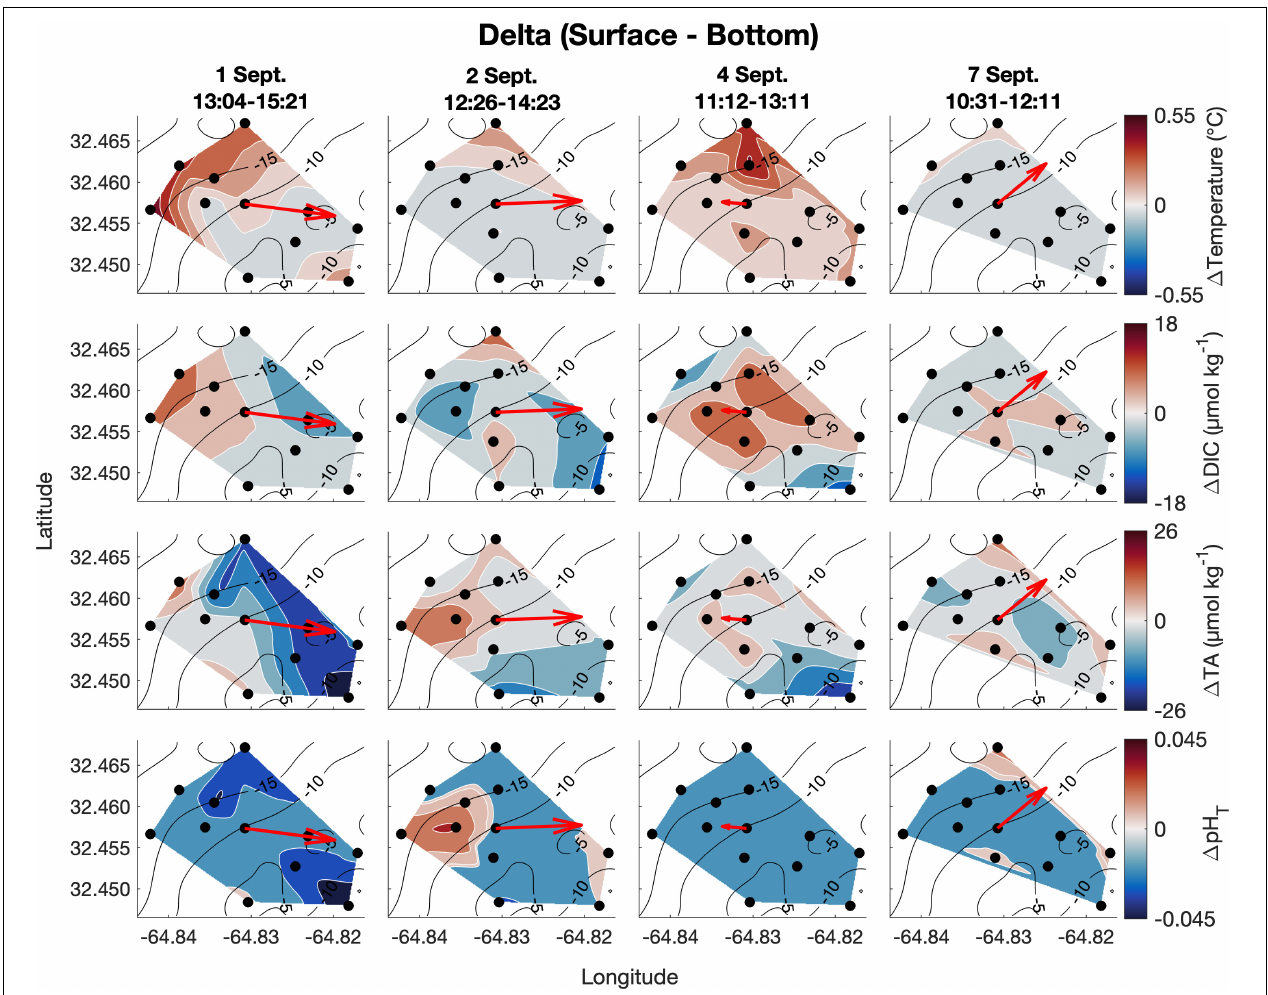
FIGURE 6 | Vertical spatiotemporal variability of the difference between surface and bottom temperature, DIC, TA, and pH T (calculated from measured DIC and TA; bottom values subtracted from surface values) on September 1, 2, 4, and 7. Plots also contain bathymetry contours (black) and the mean depth-averaged velocity vector averaged over the sampling